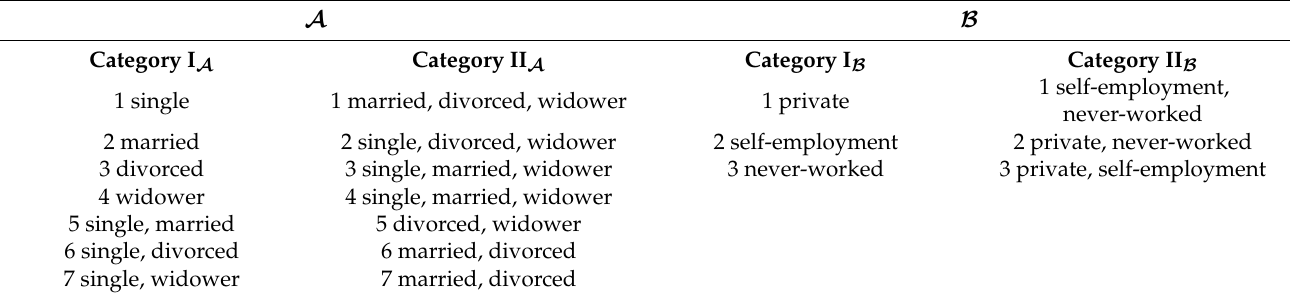
Table 3. List of all possible fusions of variables’